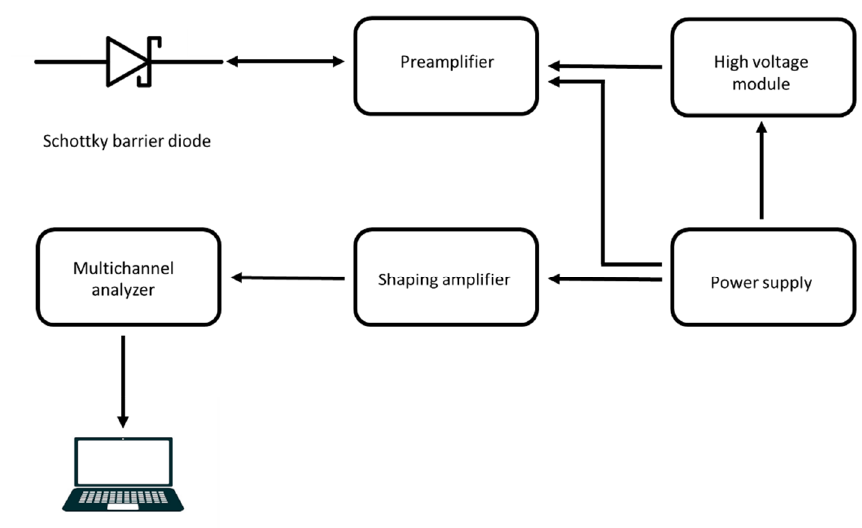
Figure 7. Block diagram of the basic detector system.